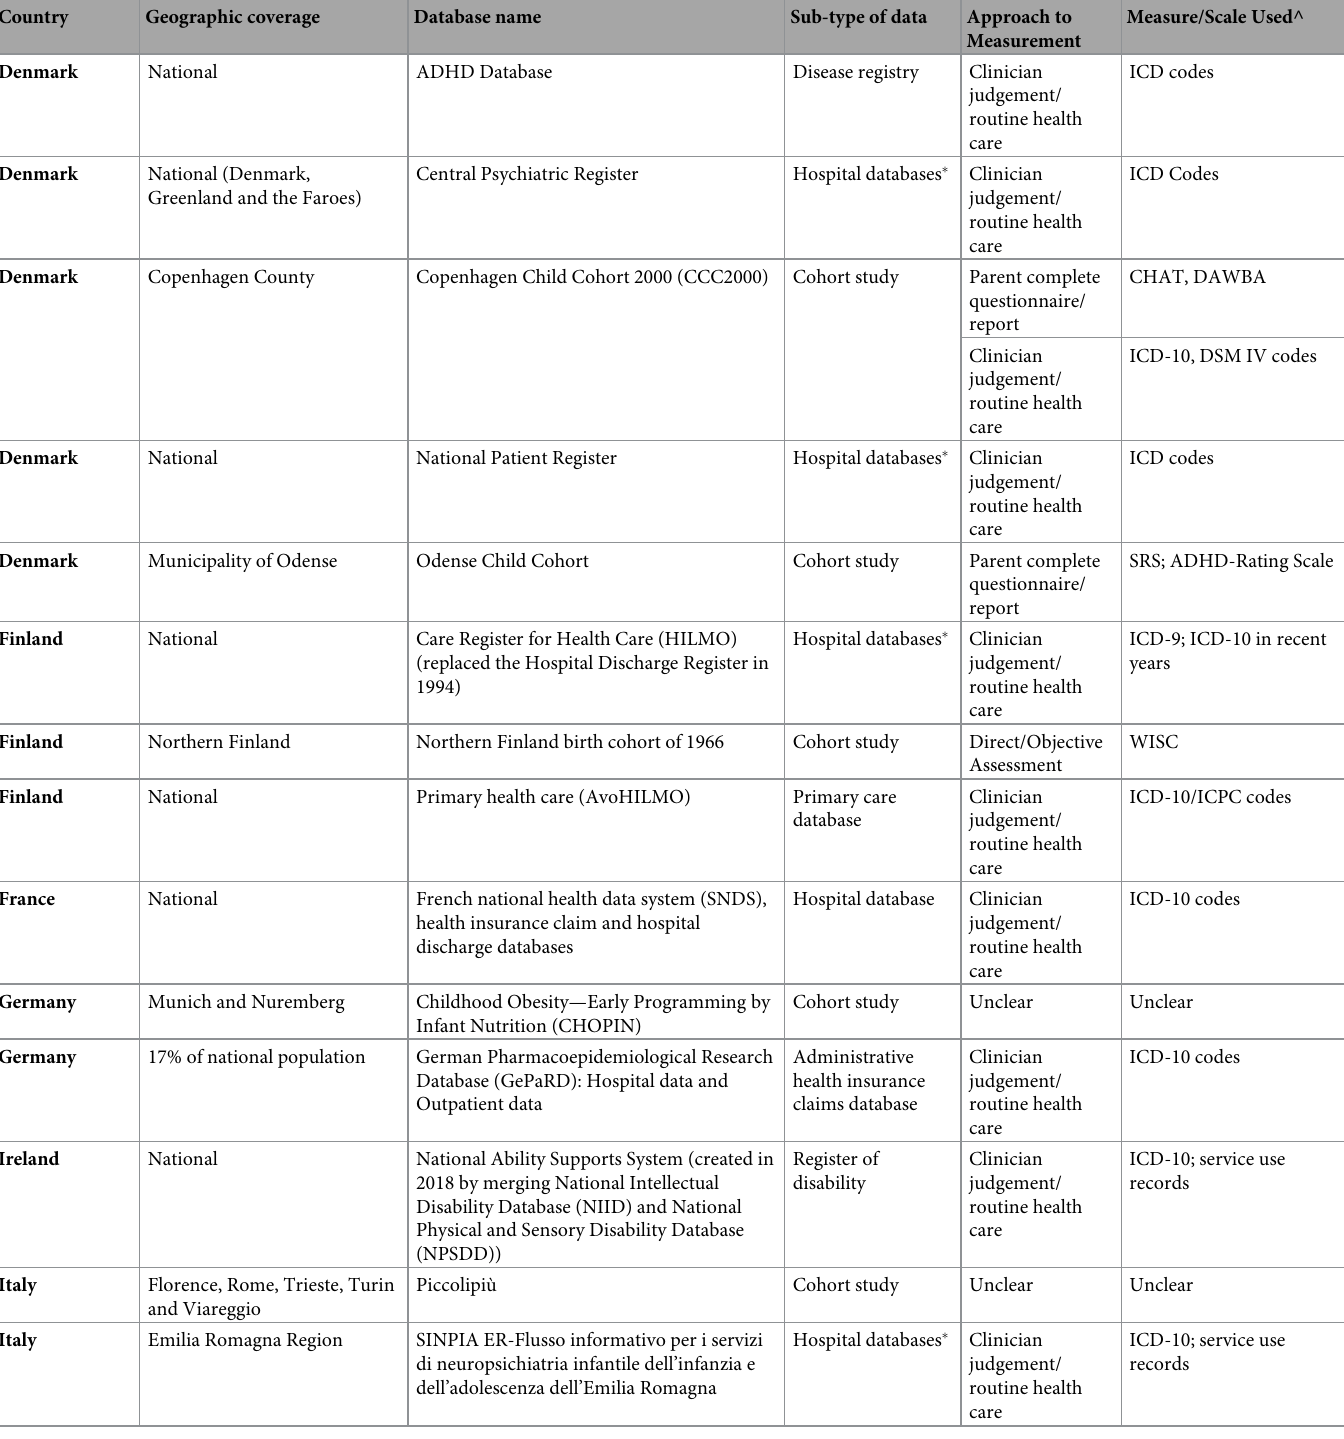
Table 5. Data sources which record neurodevelopmental